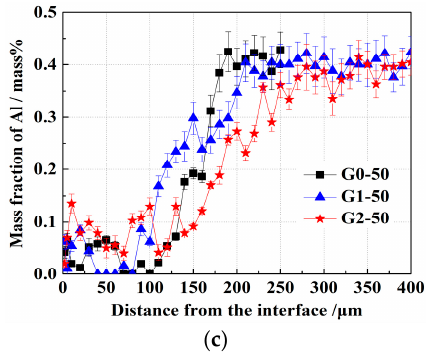
Figure 8. Effect of FeO content in the oxide on Al content in the alloy of diffusion couple G0, G1, and G2 before and after heat treatment at 1473 K: ( a ) after oxide pre-melting experiment; ( b ) after heat treatment for 10 h; ( c ) after heat treatment for 50 h.